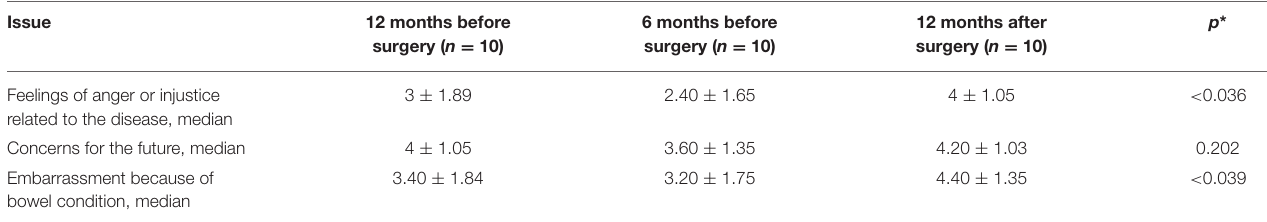
TABLE 4 | Emotional functioning score preoperatively and 6 and 12 months after surgery.